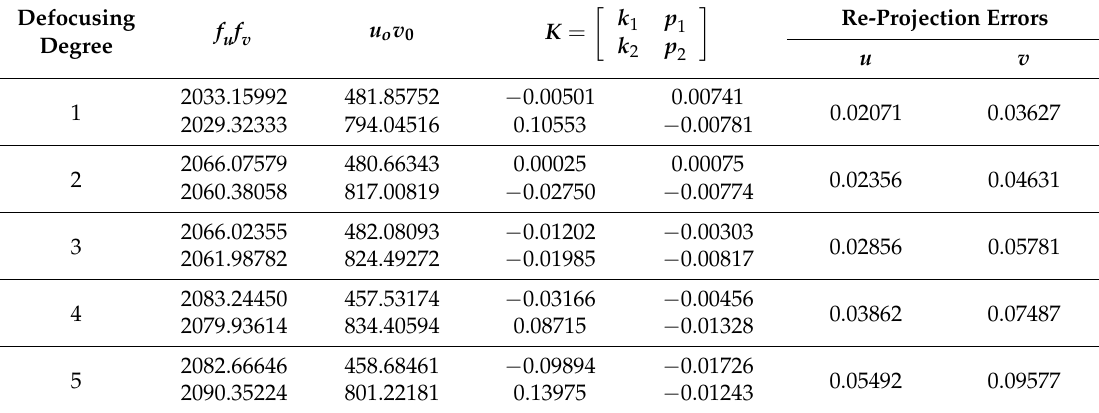
Table 1. Calibration results of a projector under different defocusing degrees when using the first method.